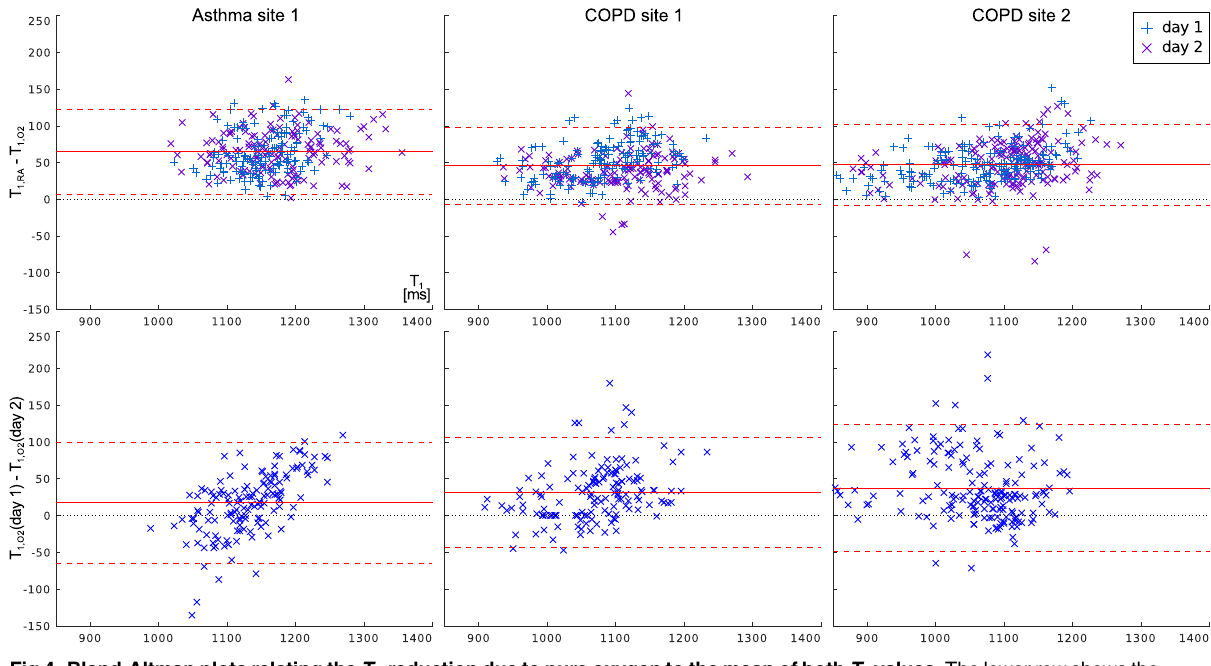
PLOS ONE | DOI:10.1371/journal.pone.0172479 February 16,